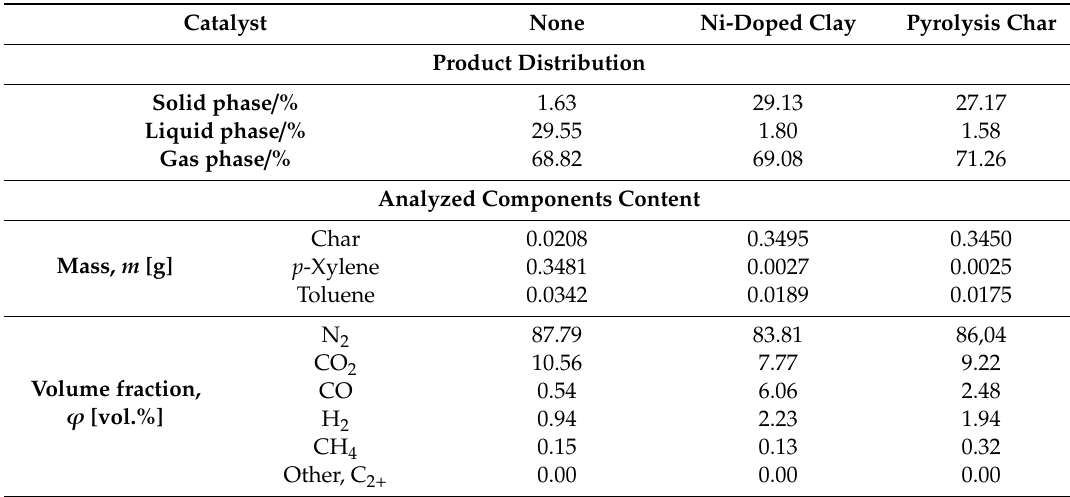
Table 4. Product distribution and principal components content in products of p -xylene